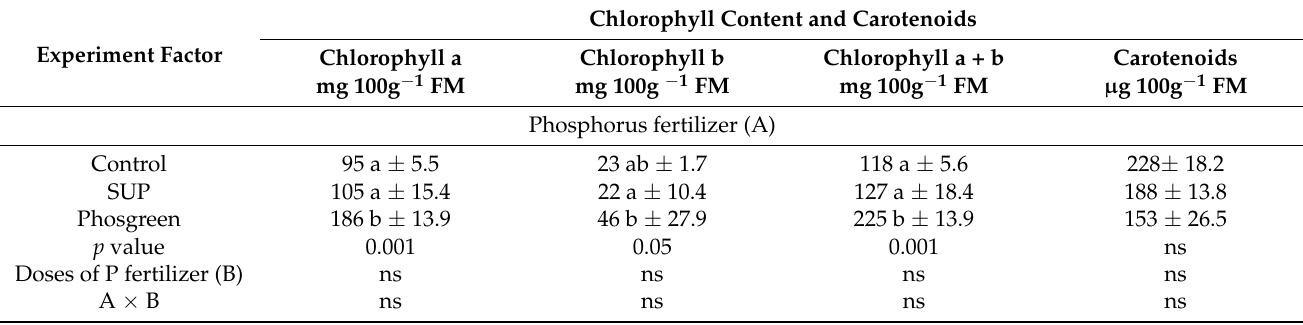
Table 1. The effect of Phosgreen and SUP fertilization on the chlorophyll content in butterhead lettuce.